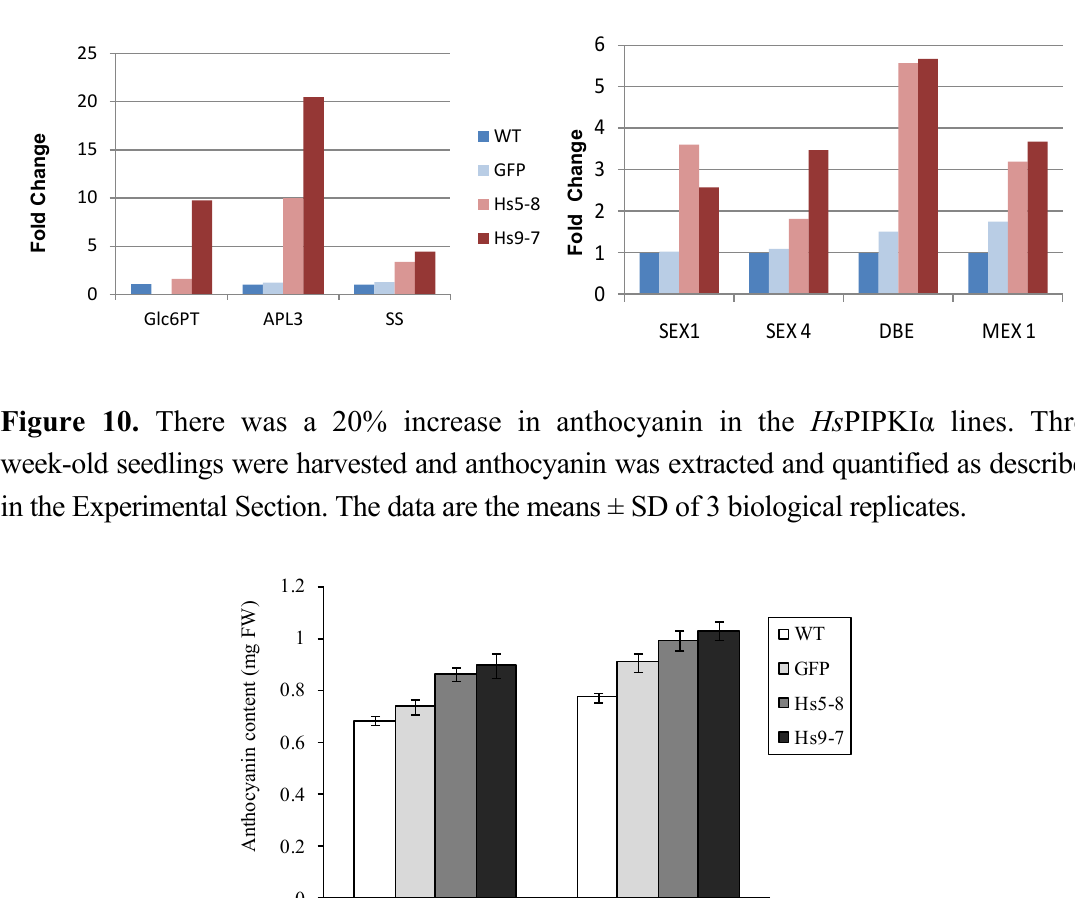
Figure 9. QRT-PCR was carried out using Full Velocity SYBR Green PCR Master Mix (Stratagene) and with the primers for genes that are involved in starch metabolism. The transcript level of each gene monitored is expressed as the fold change compared to the level of expression in the WT. The raw data (Ct values) were normalized using actin or PP2A as an internal control. The experiment was reproduced twice with similar results. Representative data are shown. Abbreviations: Glc6PT (glucose-6-phosphate transporter),